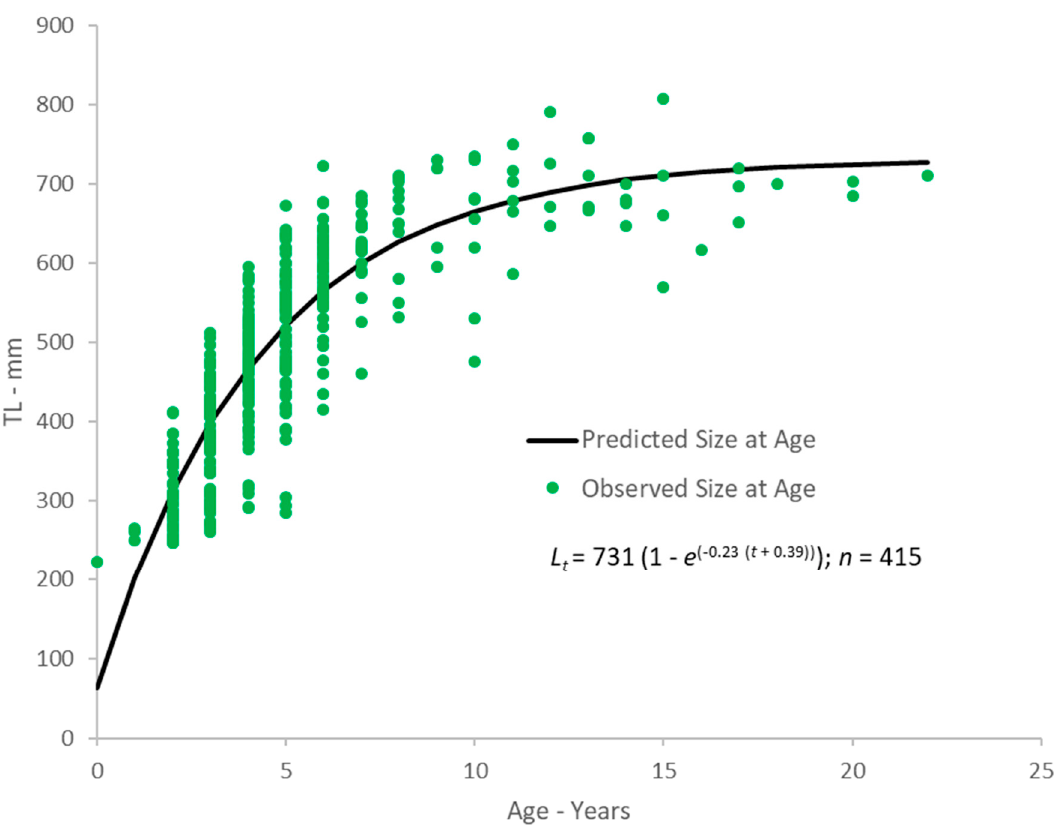
Figure 4. Comparison of observed size-at-calendar-age of margate ( Haemulon album ) to the predicted von Bertalanffy growth curve for fish from the Southeastern United States. Table 2. Observed and predicted mean total length (TL) from the von Bertalan ff y growth model, measured in millimeters, and natural mortality at calendar-age [18] data for black margate ( Anisotremus surinamensis ) collected from 1979 to 2017 from the east coast of Florida. Standard errors of the means (SE) are provided in parentheses.